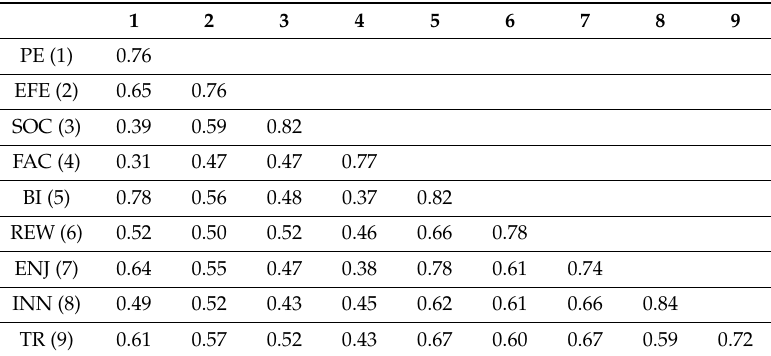
Table 6. Inter-correlations and square roots of average variance extracted.